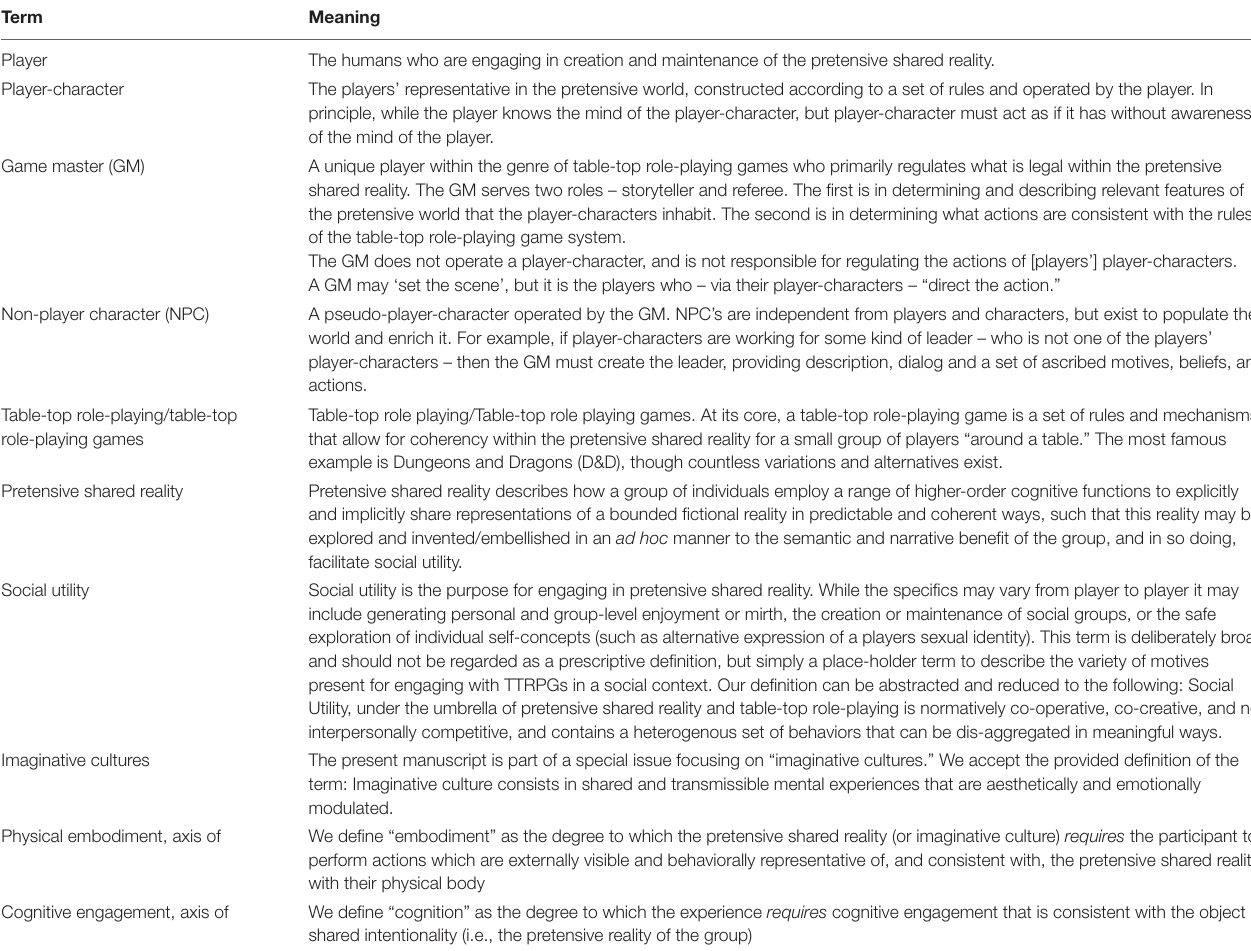
TABLE 1 | Glossary of key terms and acronyms. Term Meaning